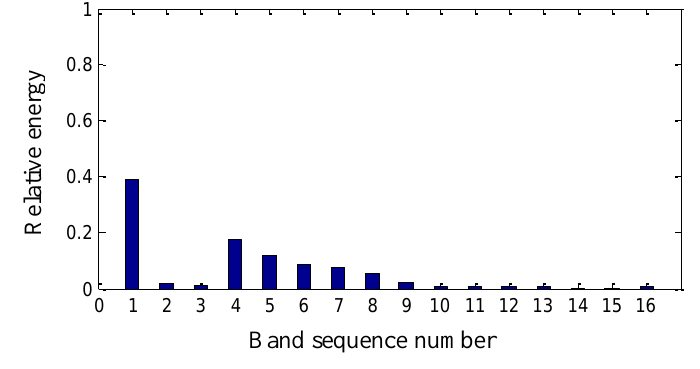
Figure 12. Wavelet package energy distribution in level